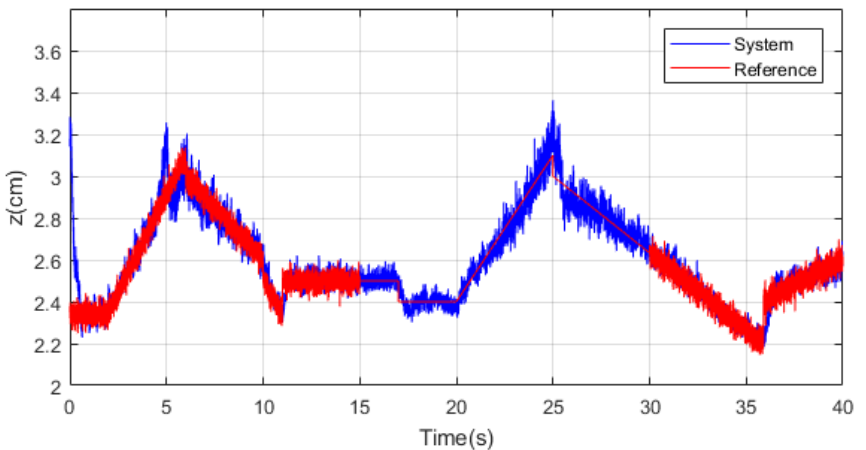
Figure 25. Random reference and system response with the inverse model controller with adap- tive block.